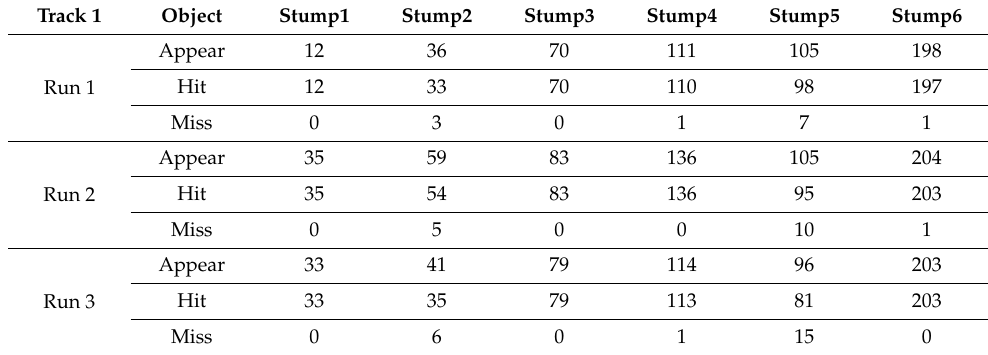
Table 2. The detection results of the detector on the target objects in Track 1.